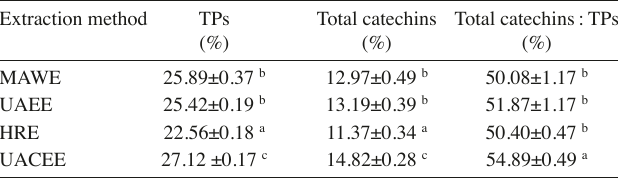
Tab. 5: Comparison of the results of UACEE and other extraction methods. Extraction method